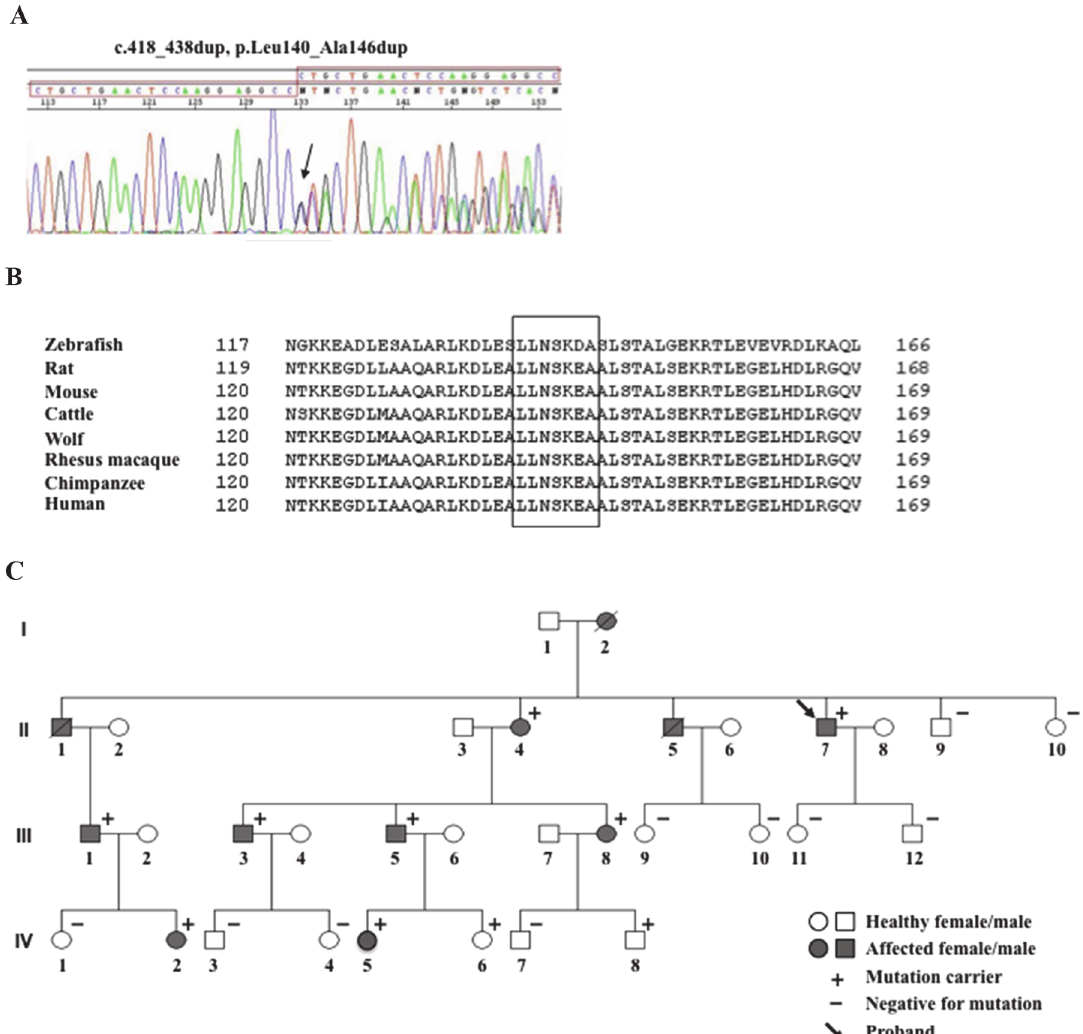
Fig 1. Family pedigree and mutation identification. (A) Electropherogram of the LMNA gene variant. (B) The 7 duplicated amino acids (LLNSKEA) are highly conserved among LMNA gene homologs in vertebrates. (C) Family pedigree of the index patient with the novel LMNA gene